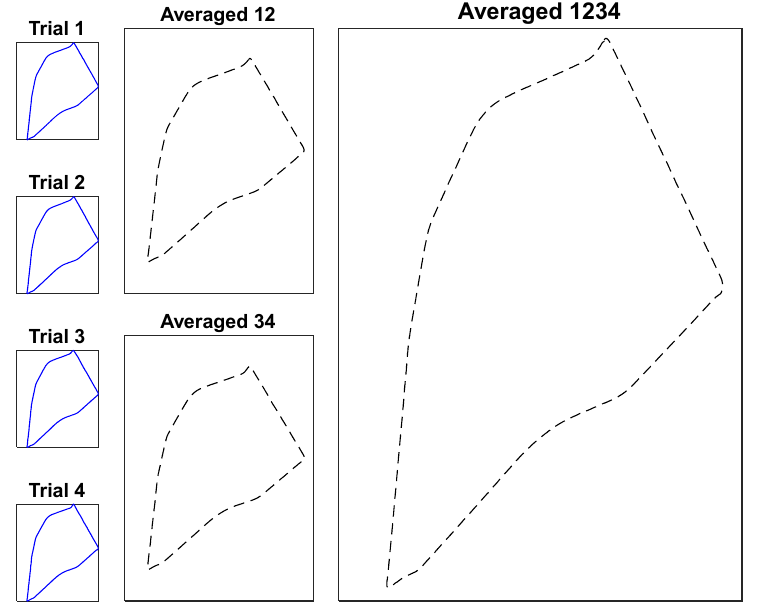
Figure 5. Diagram of the hierarchical method of averaging multiple trajectories.